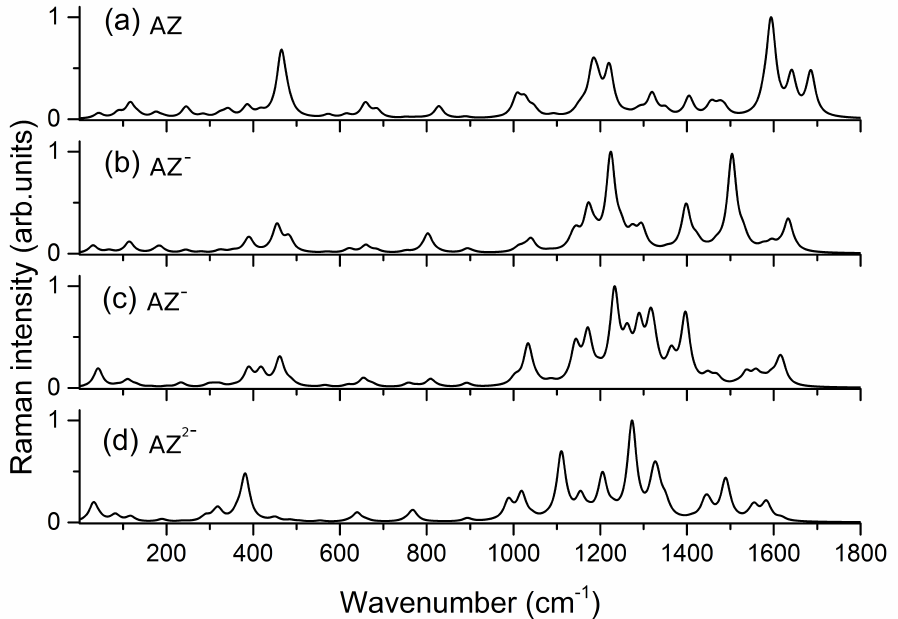
Figure 3. Computed Raman spectra for: ( a ) AZ; ( b ) AZ − (deprotonation on the oxygen atom bound to C1); ( c ) AZ − (deprotonation on the oxygen atom bound to C2); and ( d ) AZ 2 − .